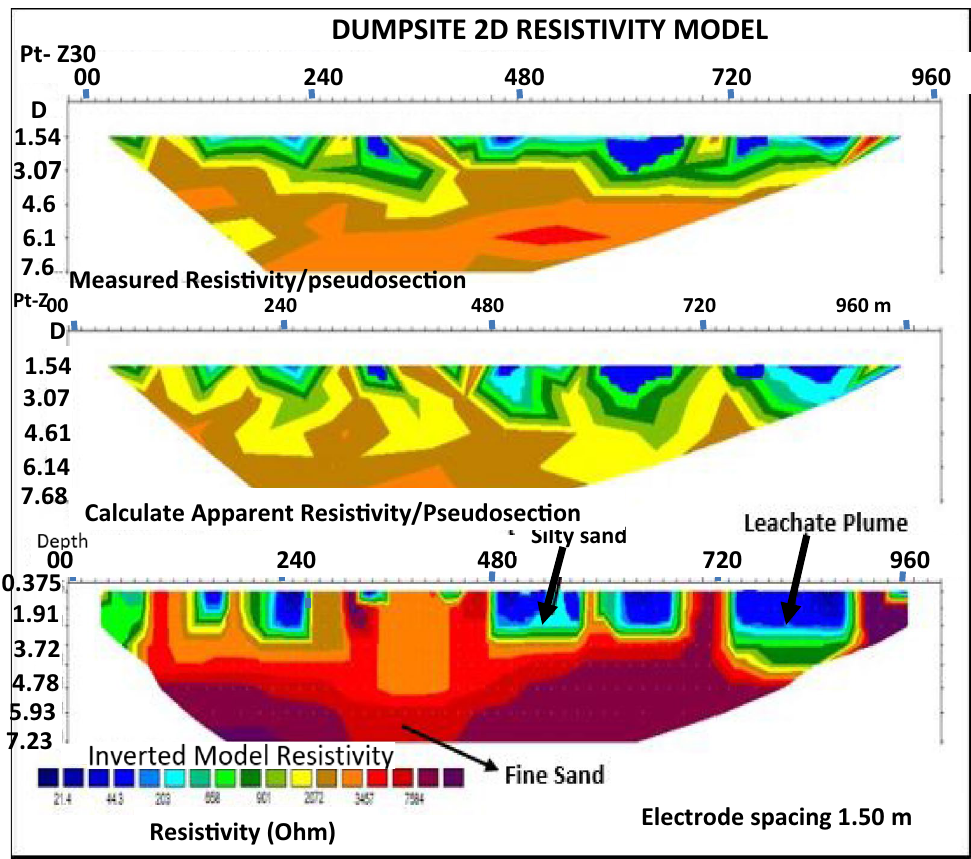
Figure 8. 2D inversion of the Wenner-array data along profile 4 (control) showing variation in resistivity in the subsurface, with blue colour representing least resistivity and red colour showing highest resistivity